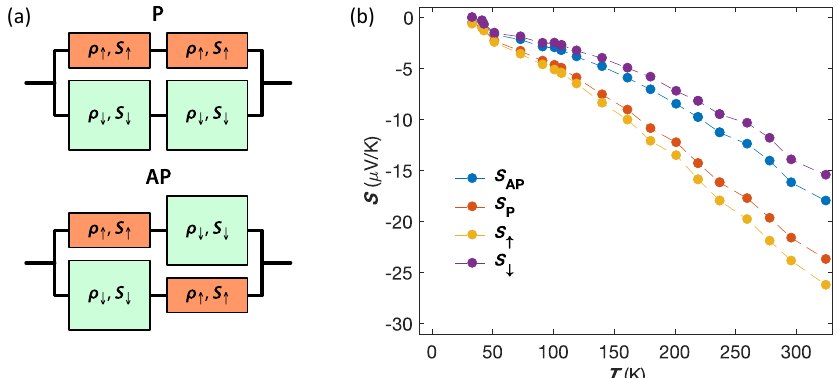
Figure 14. ( a ) the two-current model for the resistivity and the thermopower considering both parallel (P) and antiparallel (AP) magnetic configurations; ( b ) measured Seebeck coefficients at zero applied field S AP (blue circles) and at saturating magnetic field S P (red circles) of a CoNi/Cu NW network 80 nm in diameter and 3% packing density, along with the corresponding calculated S and S (violet circles) from Equations (11) and (12) (from ↓